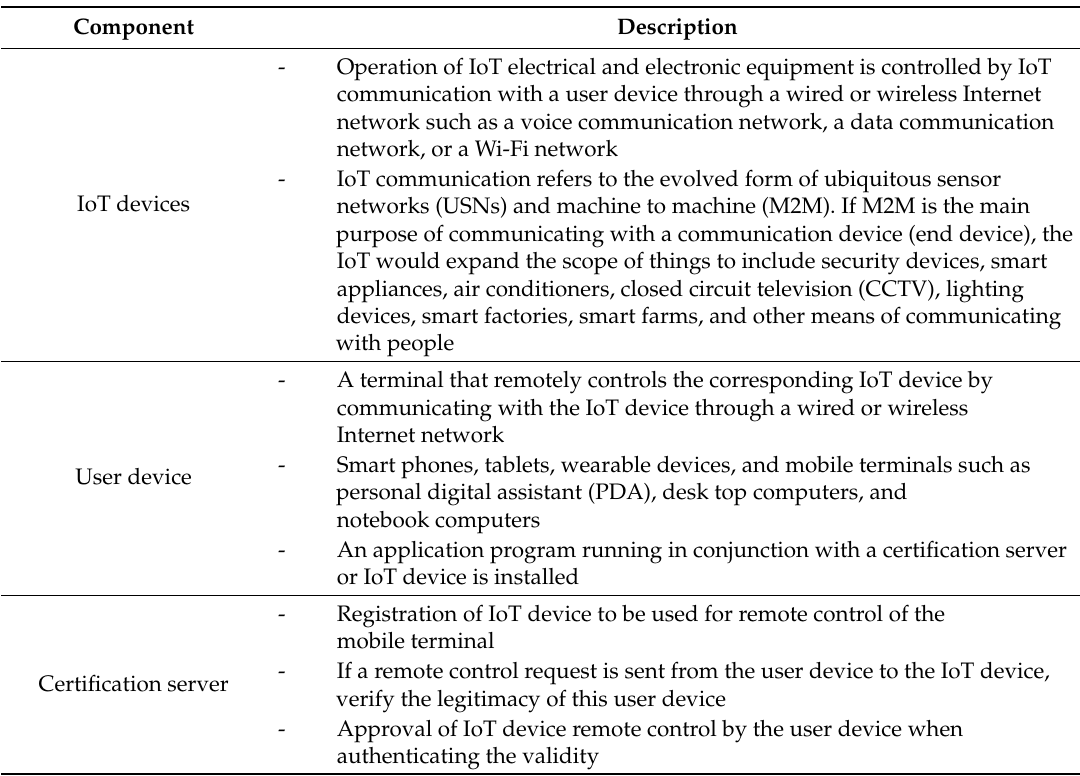
Figure 1. Conceptual Design of Security Authentication System. Table 3. Role of multiple security certification system components between IoT devices.